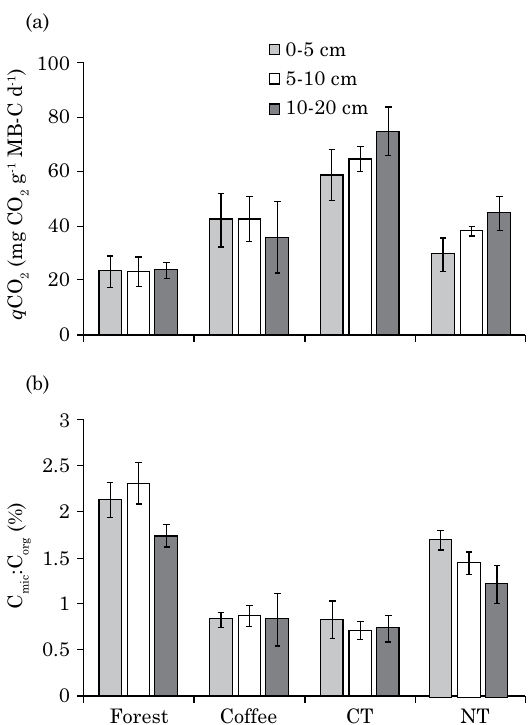
Figure 4. Mineralization of carbon (a) and nitrogen (b) during 24 days, and C:N mineralization ratio (c) of a Brazilian Oxisol after forest conversion to a perennial crop with coffee or annual grain crops (maize and soybeans) in conventional tillage or no-tillage from three layers (0-5, 5-10 and 10-20 cm). Average of three replications. Bars indicate standard